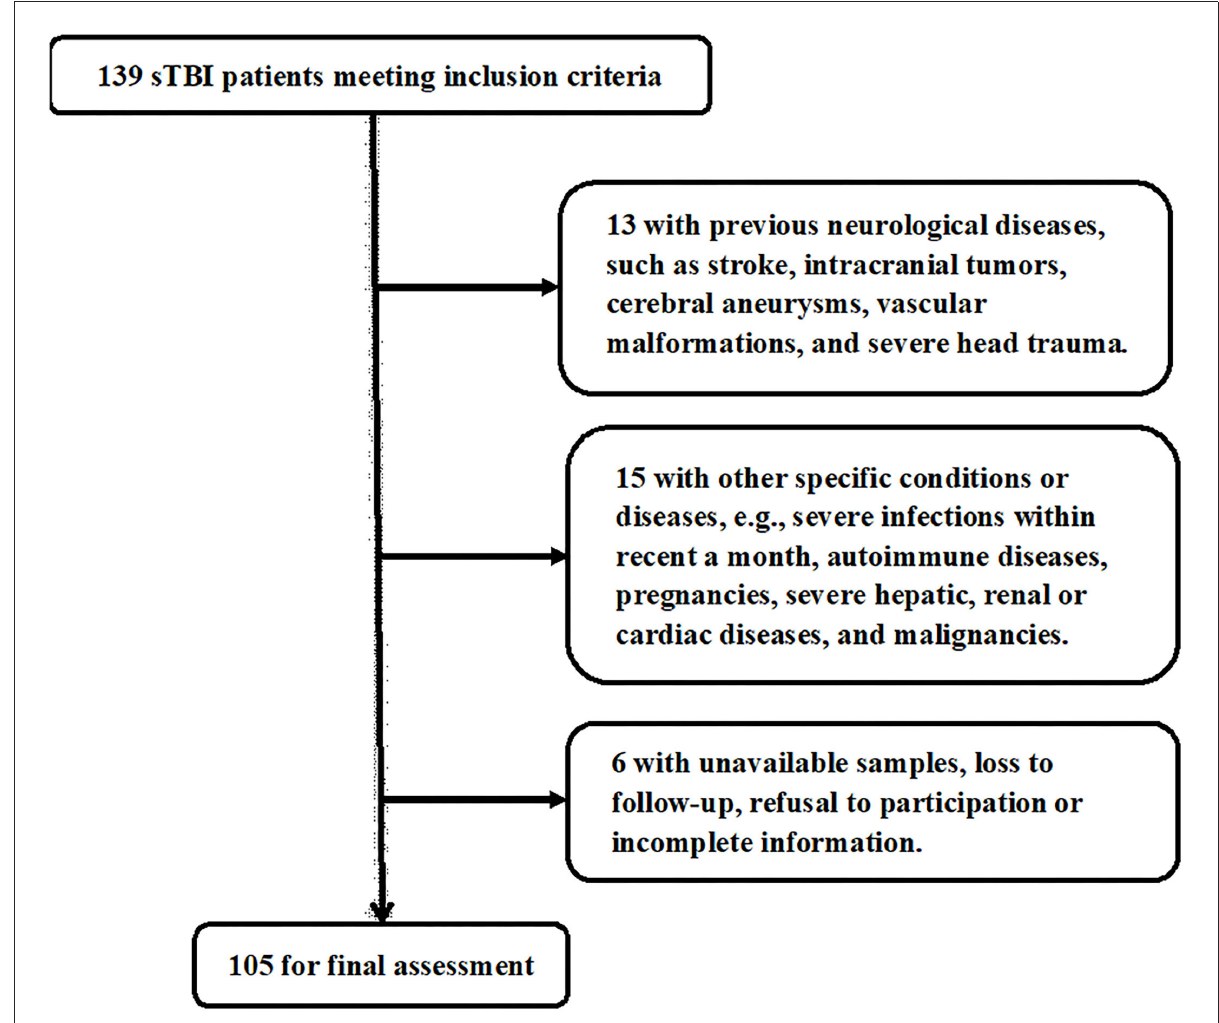
FIGURE1 Flowchart for selecting eligible patients with severe traumatic brain injury. Among 139 patients with severe traumatic brain injury, who conformed to preset inclusion criteria, a total of 34 patients were excluded, and 105 patients were eventually assessed for further analysis. sTBI denotes severe traumatic brain